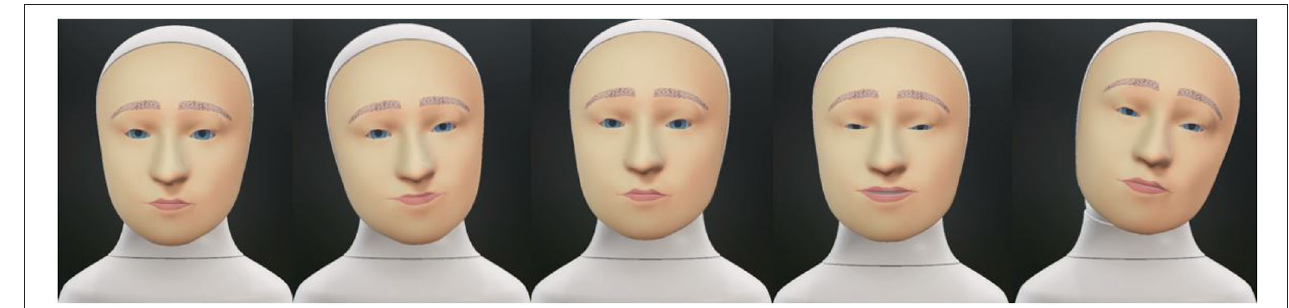
FIGURE 7 | Visual impressions of the visual Furhat robot, as used during experiment